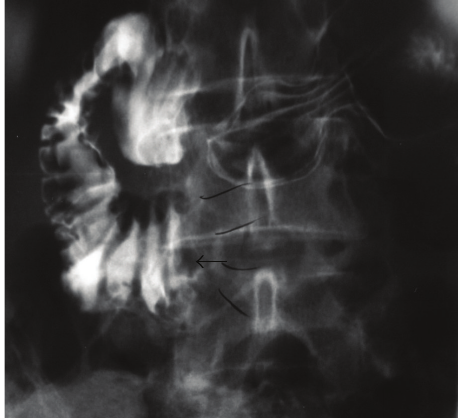
Figure 2: Upper GI demonstrates obstruction at the 3rd portion of the duodenum. Arrow indicates the cut-o ff sign.